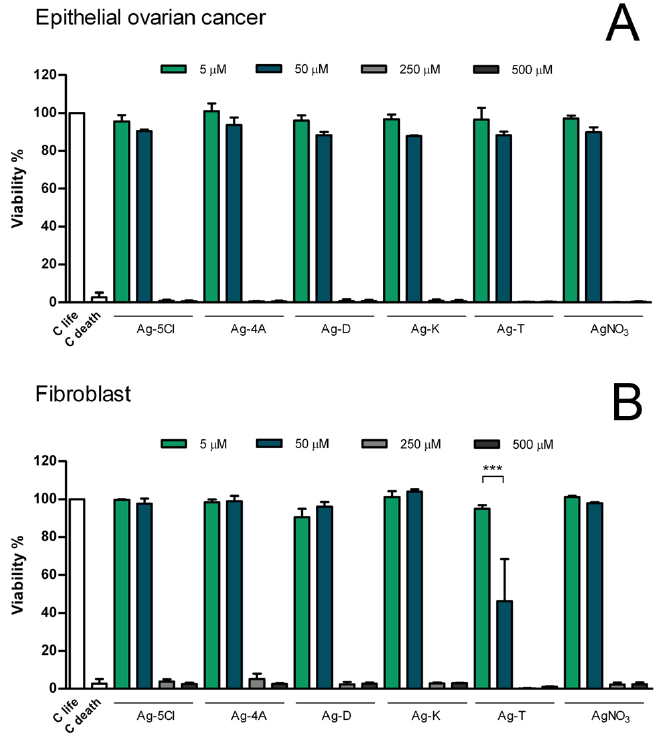
Figure 8. Evaluation of cellular viability in human cell lines. The viability of fibroblasts ( A ) and epithelial ovarian cancer cells ( B ), were evaluated after 24 h exposure to Ag coordination compounds. Results are presented as mean standard deviation of three independent experiments. For all treatment at 5 and 50 µM no statistical significance was found compared with control. *** = p < 0.001.